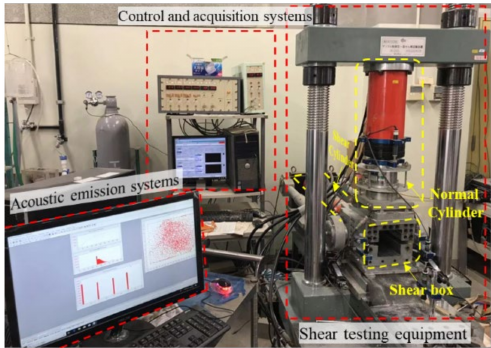
Figure 2. Experimental setup.